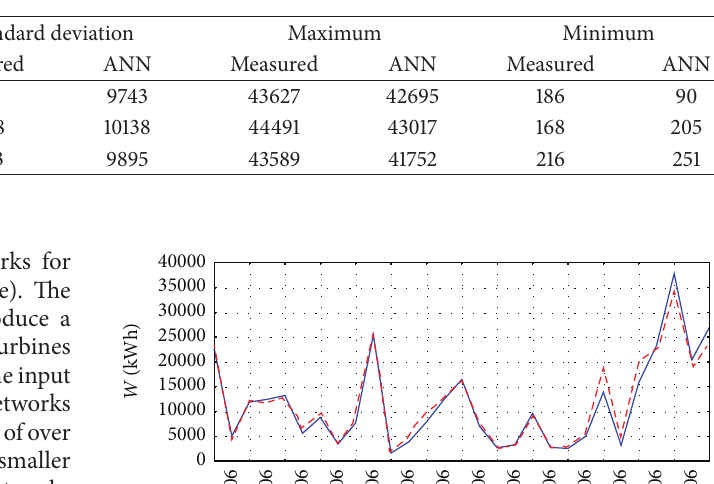
Table 4: Descriptive statistics of the measured MES time series and the time series modeled by the best artificial neural network ANN calculated over all available daily values.